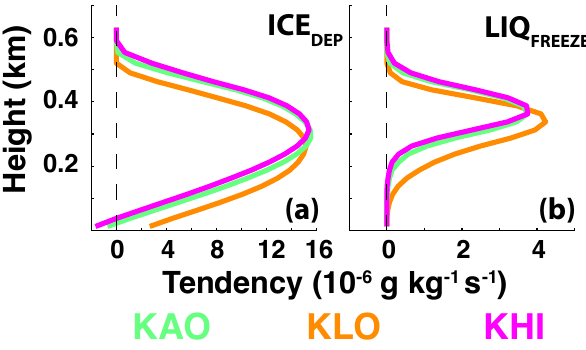
Fig. 13. Vertical profiles of domain-averaged microphysical tenden- cies for the second half of the 12h simulation period from simula- tions featuring different aerosol concentrations (color coded at bot- tom). All simulations assume kaolinite as the insoluble mass type Included are profiles of ice depositional growth tendency (a) and liquid freezing tendency (b)